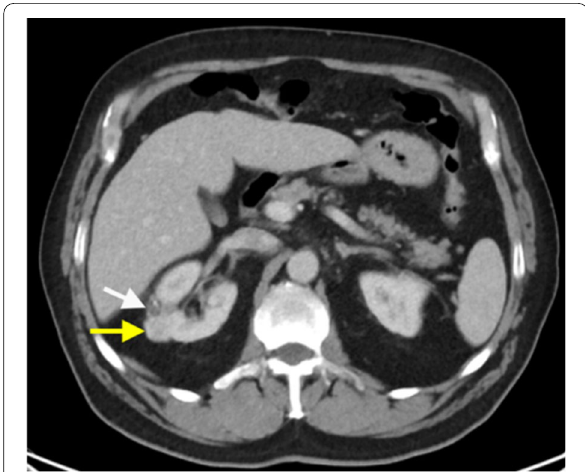
Fig. 15 Axial contrast-enhanced CT image of recurrent renal cell carcinoma at a partial nephrectomy site at the mid-pole of the right kidney, as demonstrated by nodular enhancement (yellow arrow) at the site of the partial nephrectomy, usually hypodense (white